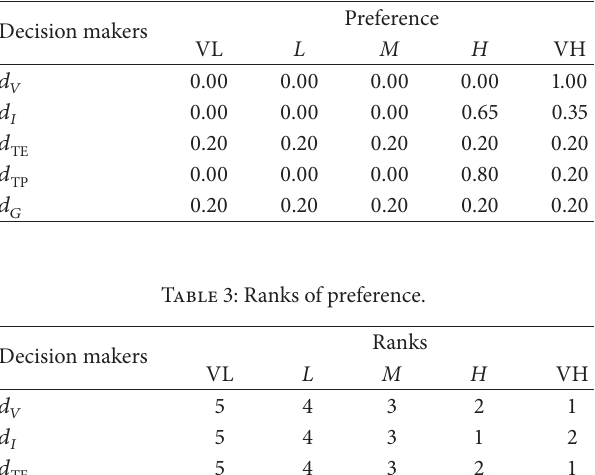
Table 2: Preference of different decision makers.